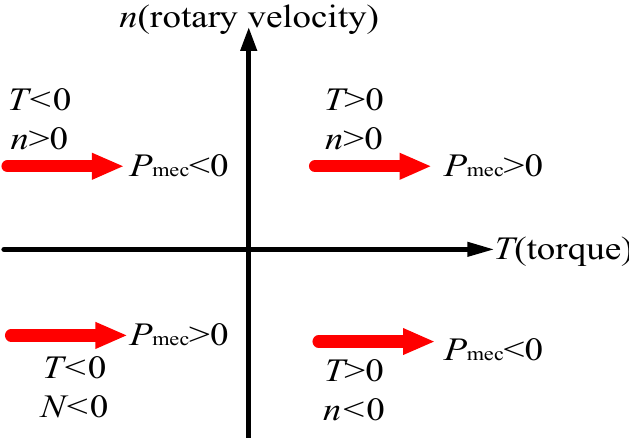
Figure 3. Diagram of the different modes of operation of the motor/generator.